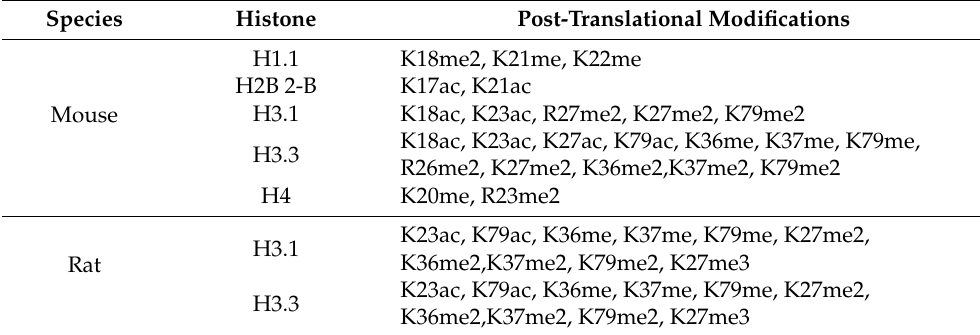
Table 2. Comparison of mass spectrometry analyses of PT histones between